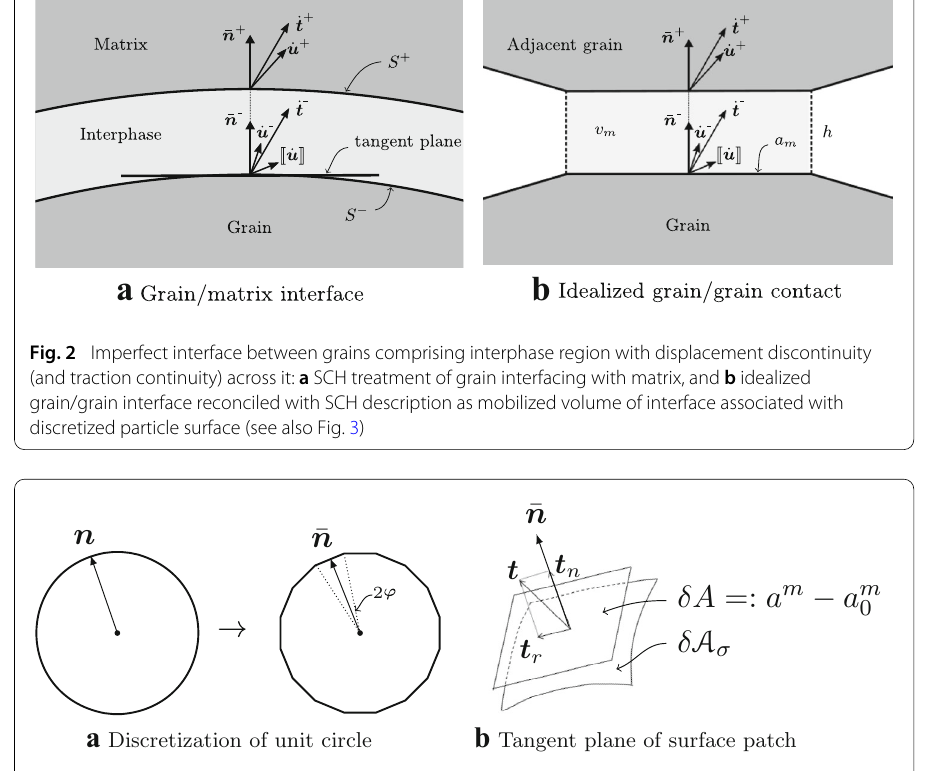
Fig. 3 Discretization of surface with tangent planes: a shown schematically as 2D unit circle with a standard normal orientation for discretization into 16 equal parts of angle 2 ϕ (dotted lines); b surface patch of